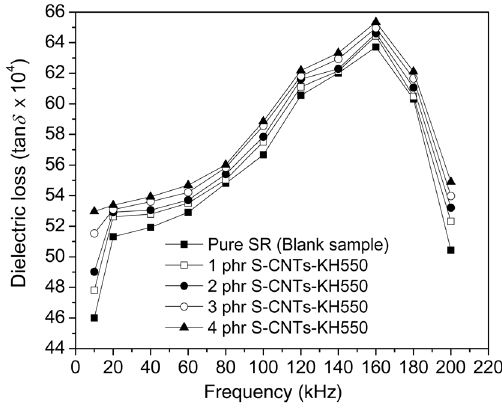
Figure 7 Dielectric loss of S-CNT-KH550/SE composites with differ- ent frequencies of outer electric